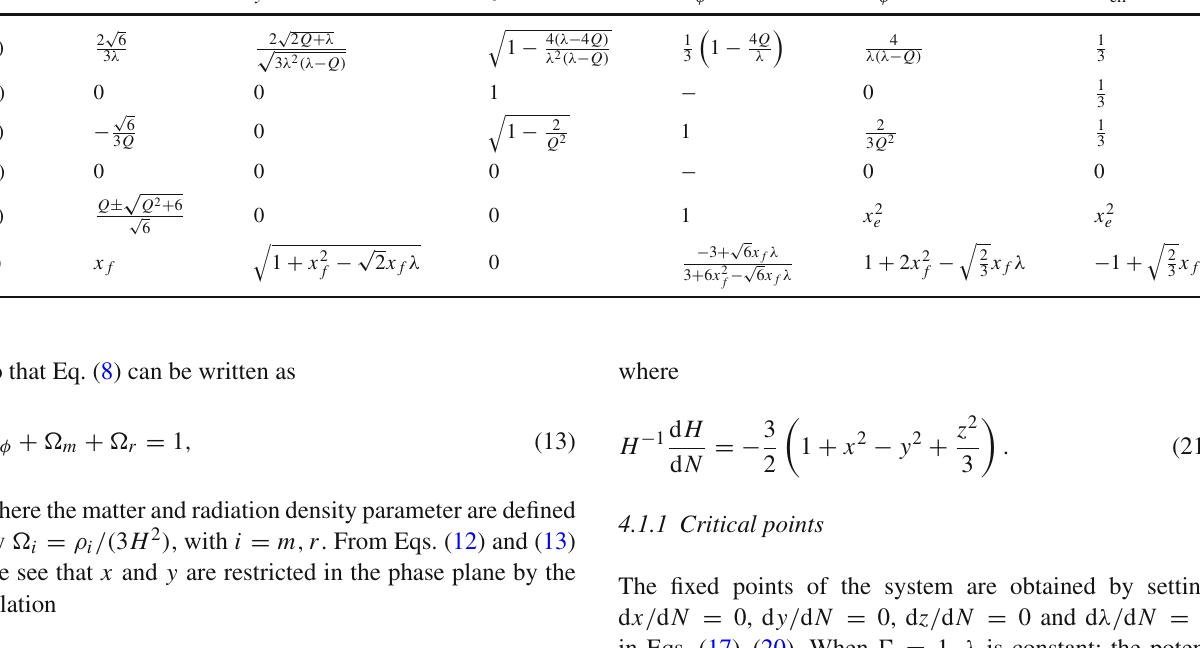
Table 1 Critical points ( x , y and z ) of Eqs. (17)–(19) for the quintessence field with interaction Q ρ φ . The table shows the correspondent equation of state for the dark energy (15), the effective equation of state (16) and the density parameter for dark energy (12)